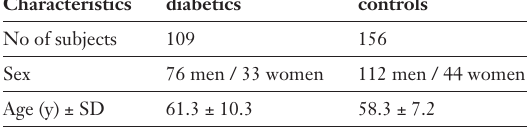
Characteristics of the test subjects.